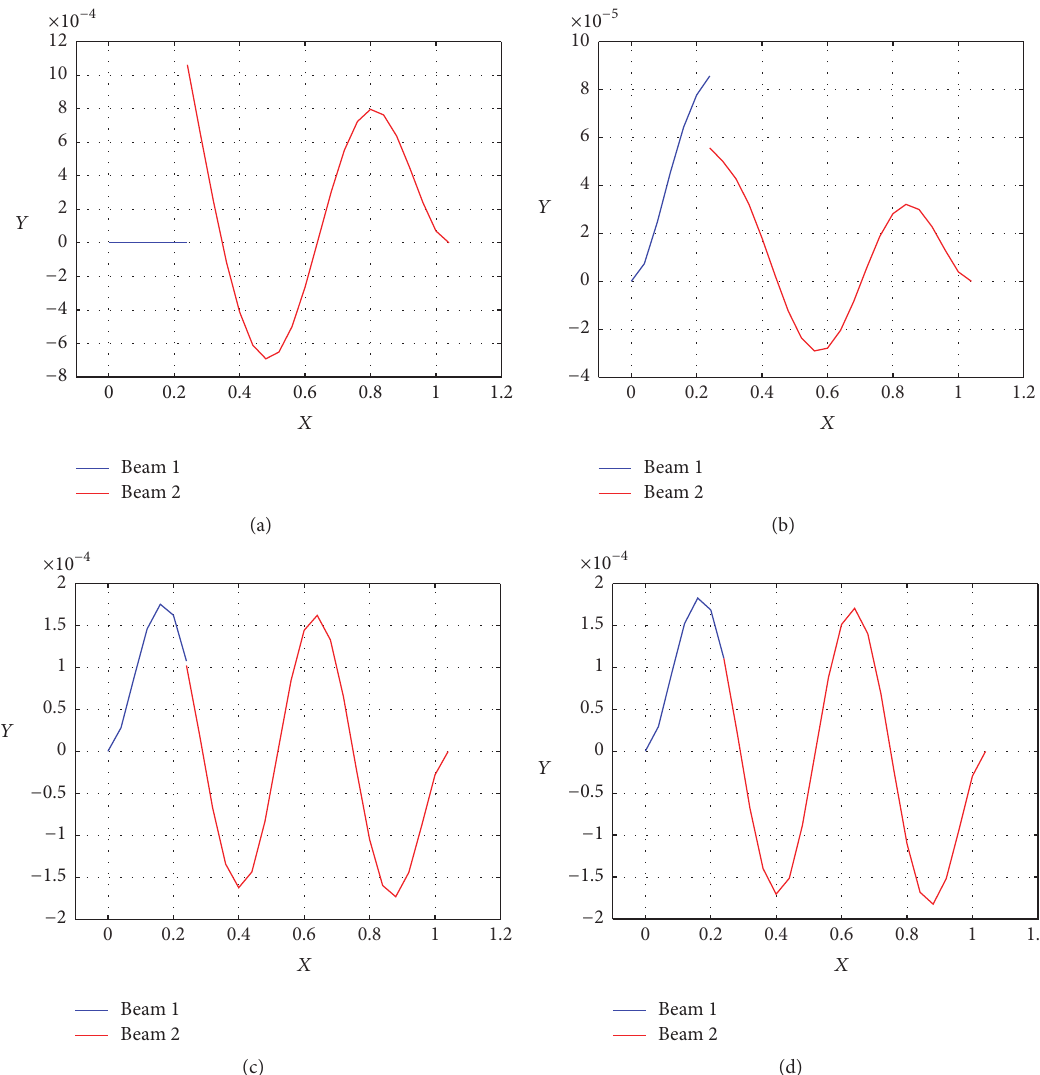
Figure 7: The fourth mode for the coupled beams with the four cases: (a) case 1, (b) case 2, (c) case 3, and (d) case 4.